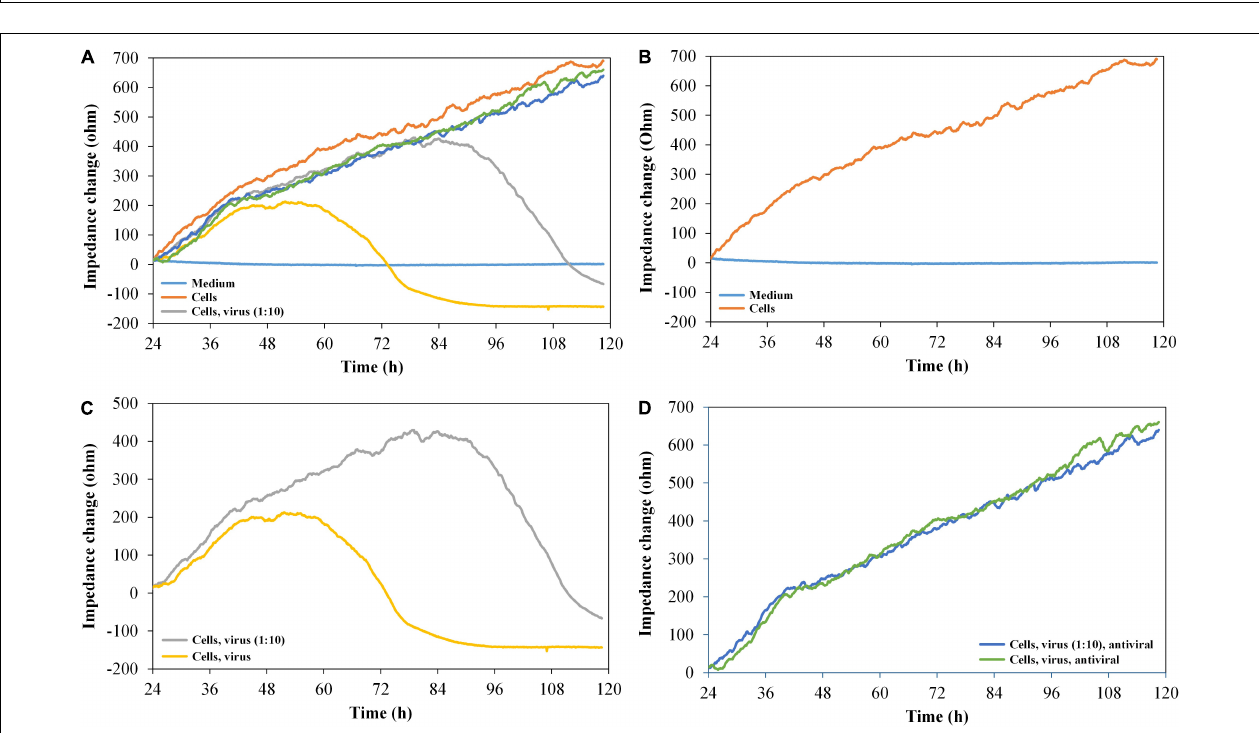
FIGURE 4 | Measurement set-up. (A) Close-up view of one of the 24 wells with sensor structures; a scale bar corresponds to 3.5 mm. (B) A well plate with sensor foil and interdigitated graphene sensors, connected with a circuit board. Different colors highlight the active wells with electrodes; each color represents one row with six wells, which are used in parallel.